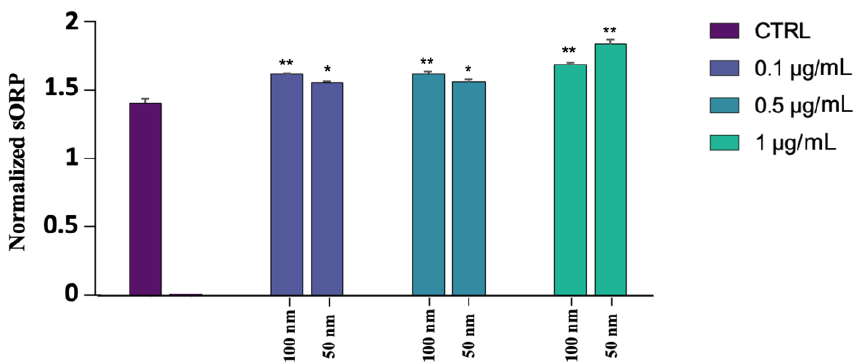
Figure 5. Normalized sORP values of spermatozoa exposed to 50 and 100 nm PS-NPs at increasing concentrations. Strong statistically differences (** p < 0.01) have been found between samples exposed to all concentration of 100 nm PS-NPs and 1 µ g/mL 50 nm PS-NPs compared to the control group. Significant data (* p < 0.05) have been found at 0.1 µ g/mL and o.5 µ g/mL of 50 nm PS-NPs.